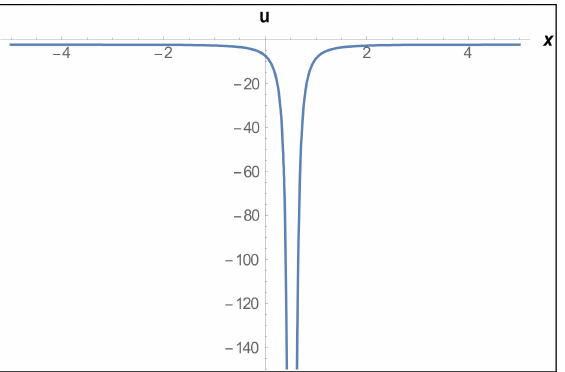
Figure 2. The 2D graph of Equation (16) under the values of d = 0.1, α = − 1.8, b = 0.5, ε = 0.4, t = 0.5, − 5 < x <